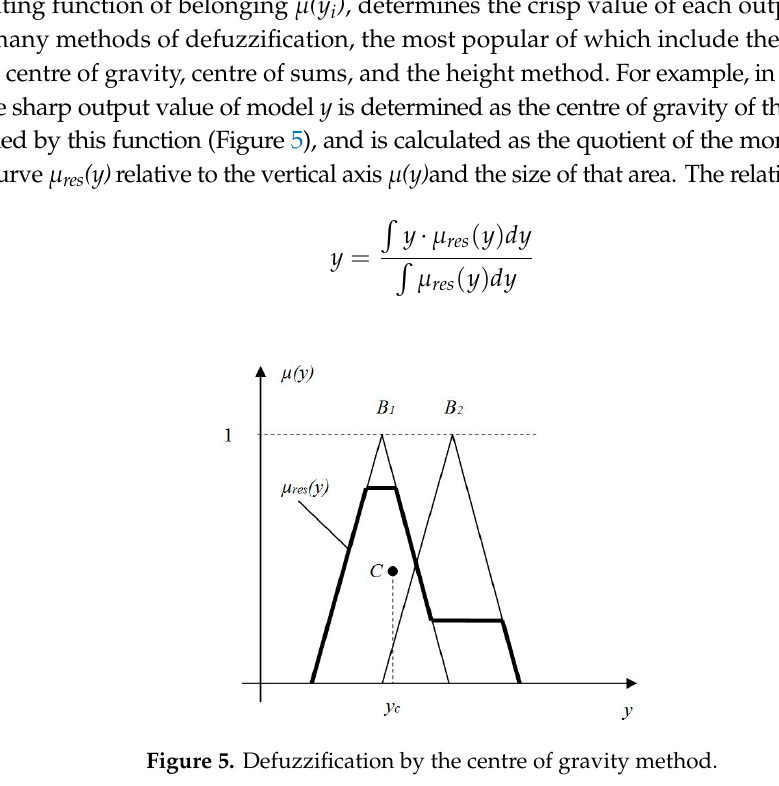
Figure 4. Classical structure of a fuzzy system.